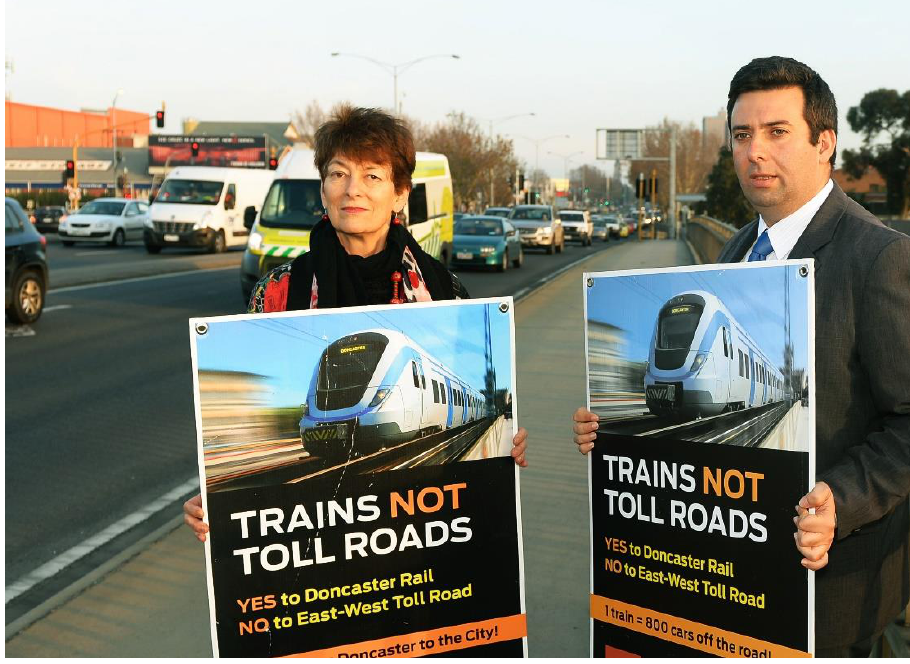
Figure 1: Yarra City Council and Moreland City Council mayors holding ‘Trains not toll roads’ placards at anti-freeway